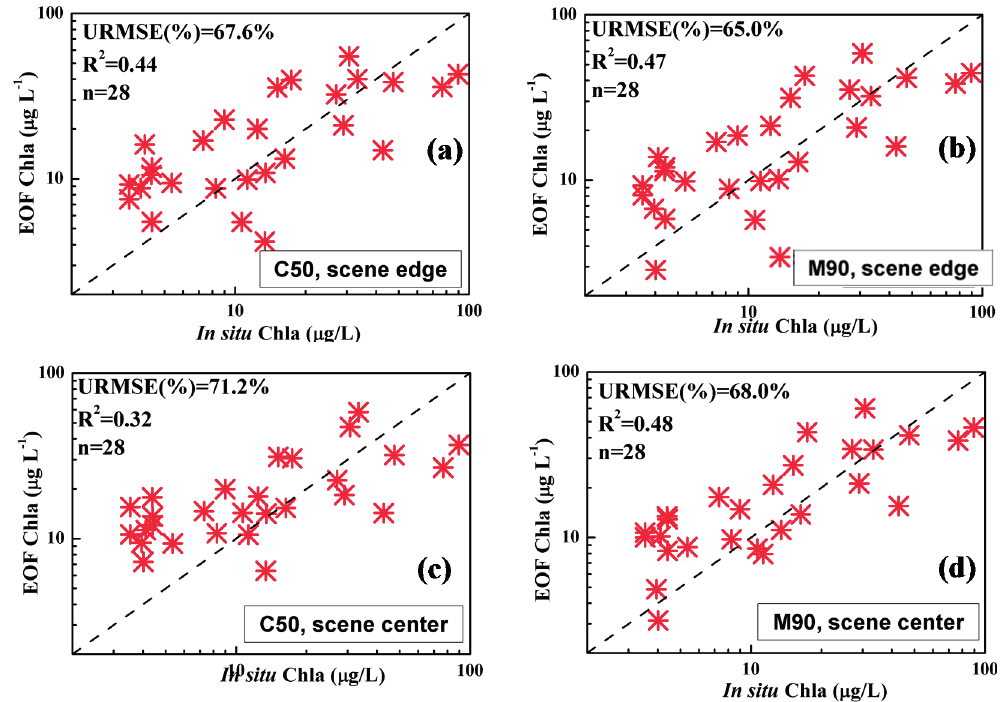
Figure 5. Sensitivity of the EOF Chla algorithm to different aerosol perturbations, derived from radiative transfer simulations. ( a ) Coastal aerosol with relative humidity of 50%, τ _869 = 0.37 at the scene edge; ( b ) maritime aerosol with relative humidity of 90%, τ _869 = 0.51, scene edge; ( c ) coastal aerosol with relative humidity of 50%, τ _869 = 0.19, scene center; ( d ) maritime aerosol with relative humidity of 90%, τ _869 = 0.23, scene